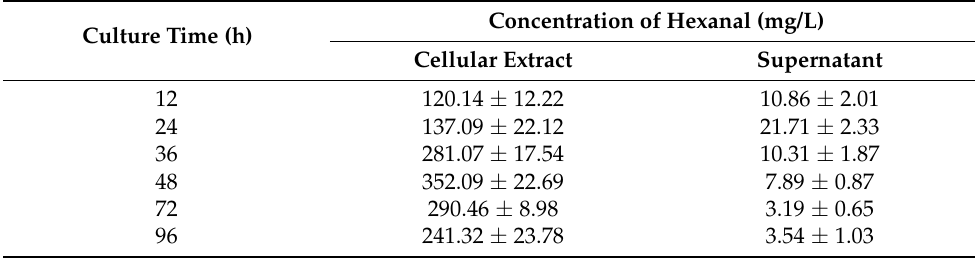
Table 3. The concentration of hexanal synthesized by Yarrowia lipolytica on the medium with linoleic acid.